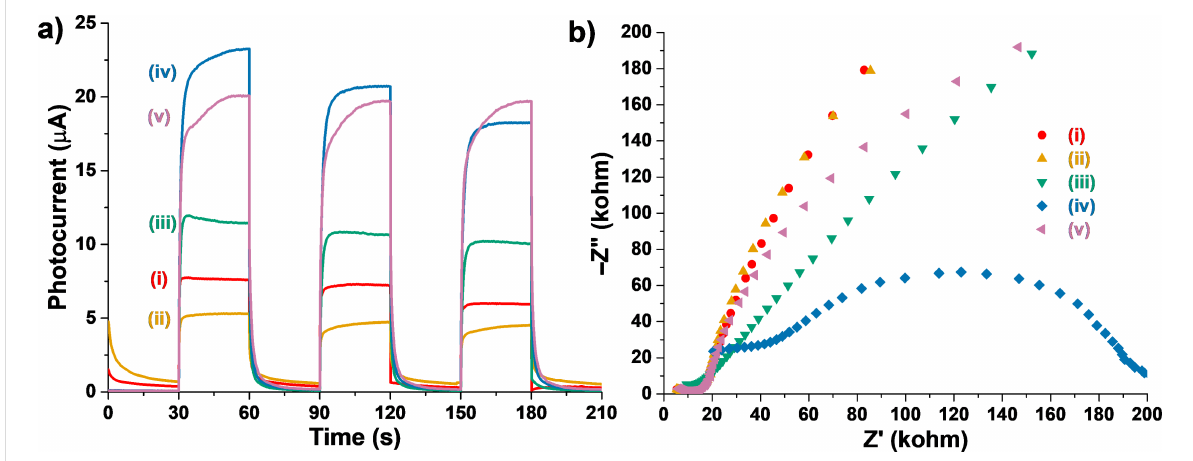
Figure 10: (a) The transient photocurrent responses and (b) EIS Nyquist plots of (i) pure Bi 2 WO 6 samples and hierarchical (ii) 30% − Bi 2 WO 6 /TiO 2 -NT, (iii) 50% − Bi 2 WO 6 /TiO 2 -NT, (iv) 70% − Bi 2 WO 6 /TiO 2 -NT, and (v) 90% − Bi 2 WO 6 /TiO 2 -NT nanocomposites.